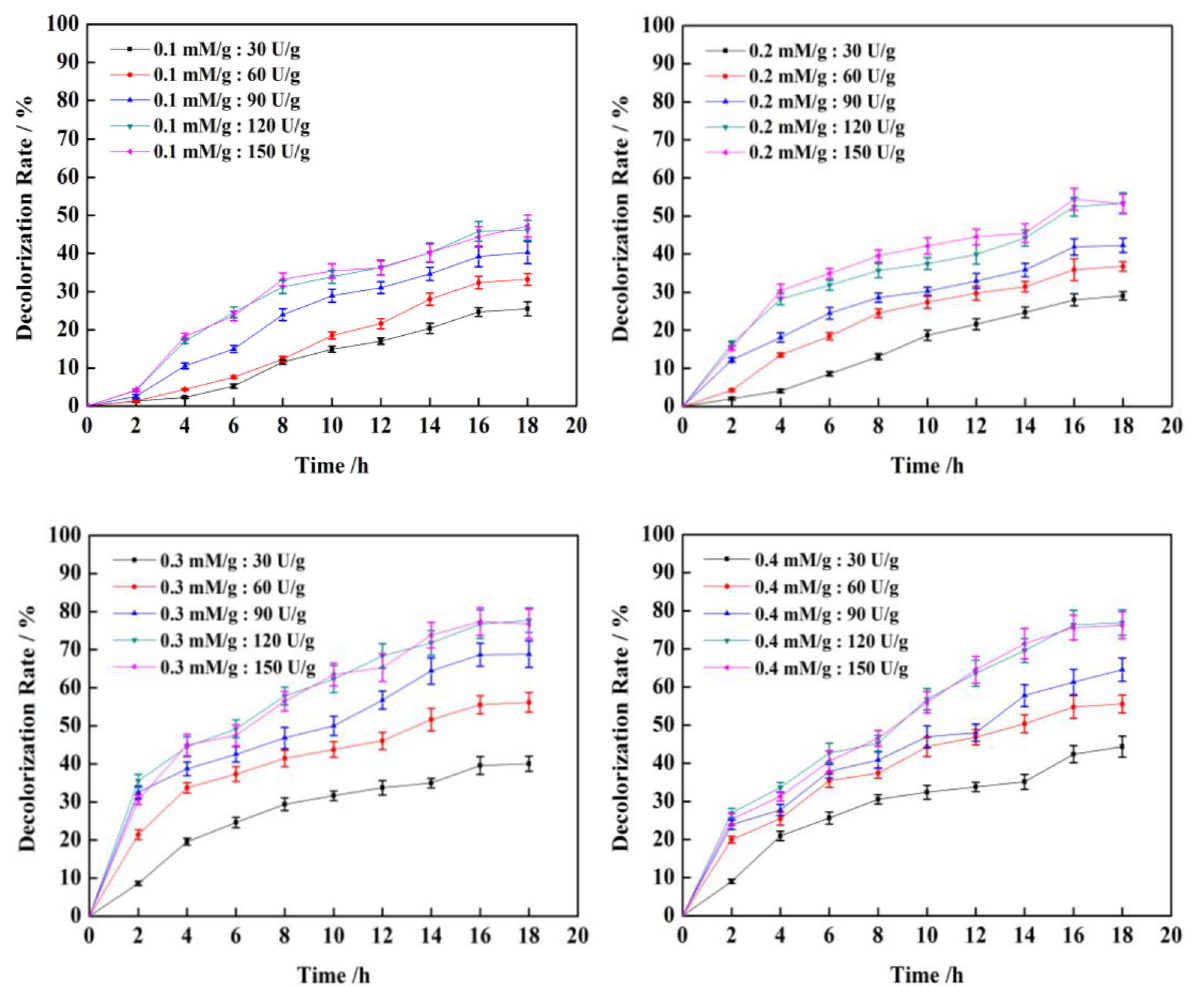
Fig. 6 Effect of the ratio of TEMPO to laccase on the co-immobilized laccase and TEMPO. The maximum decolorization rate of 77.41% was obtained when the ratio of TEMPO to laccase was 0.3 mM/g:120